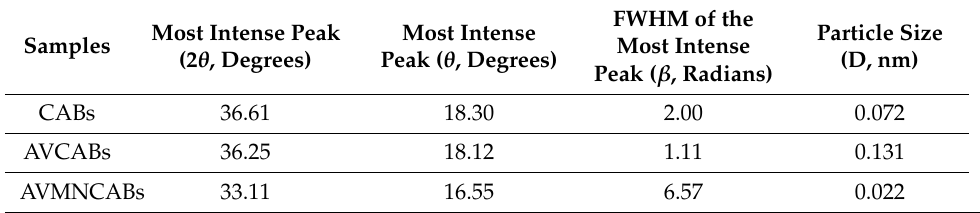
Table 1. Average crystal size of CABs, AVCABs, and AVMNCABs calculated using Debye–Scherrer’s